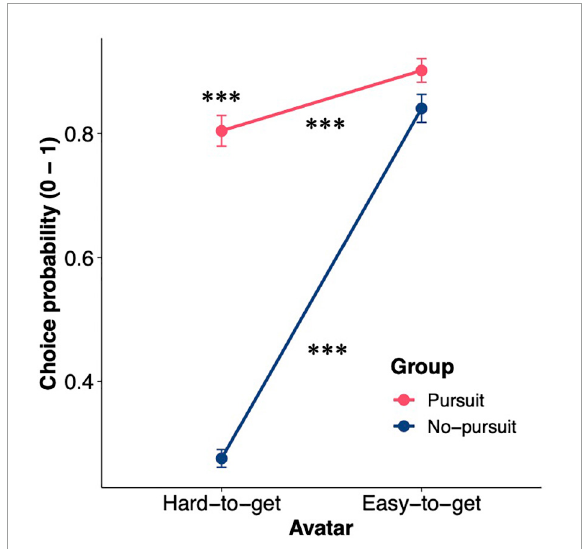
FIGURE2 Choice probability for the hard-to-get and easy-to-get avatars in the two groups. The figure shows the choice probability for the hard-to-get and easy-to-get avatars in the two groups. The error bars represent the standard error of the mean. Asterisks above points denote whether the difference in choice probability between two groups for the avatar was significant, while asterisks above or below lines denote whether the difference in choice probability between two avatars was significant in each group: ∗∗∗ p <